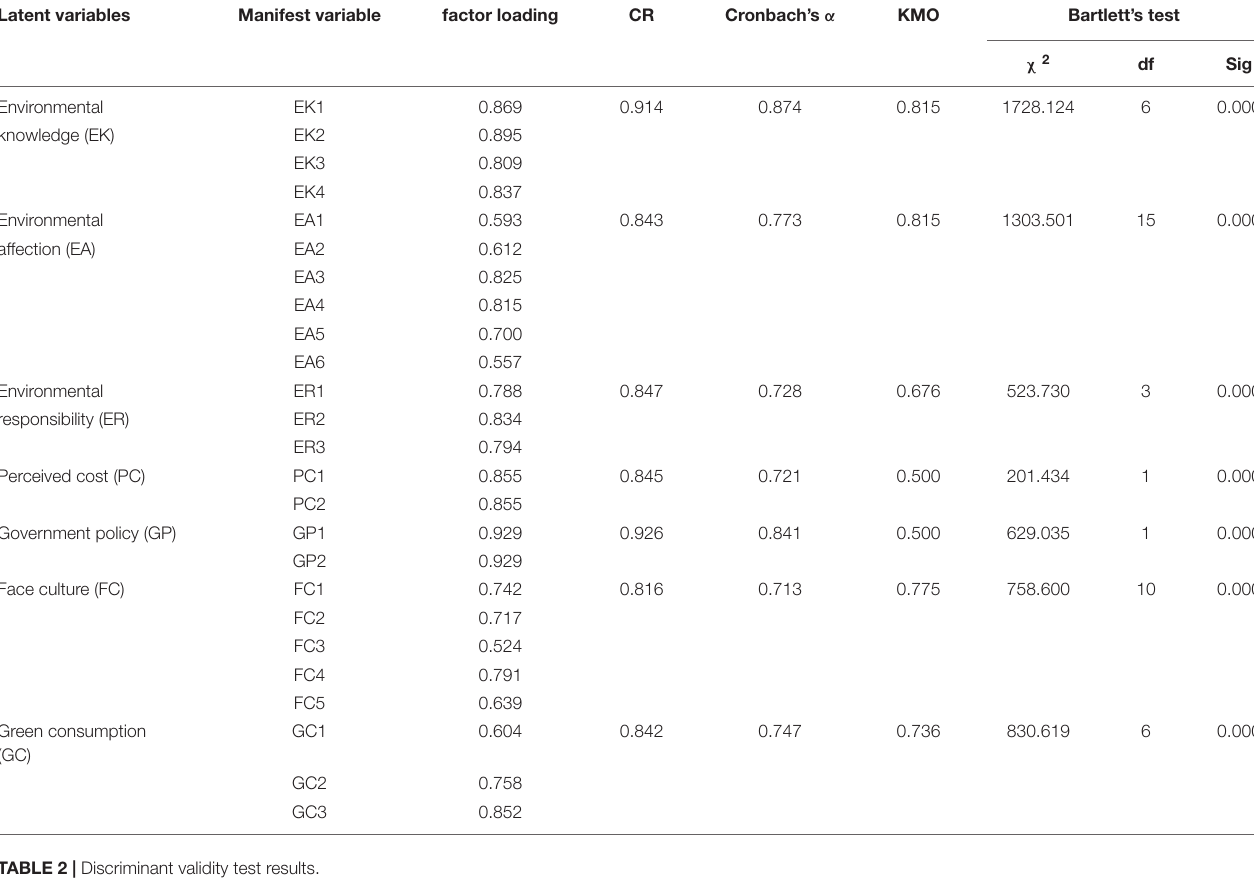
TABLE 1 | Reliability and validity test results.